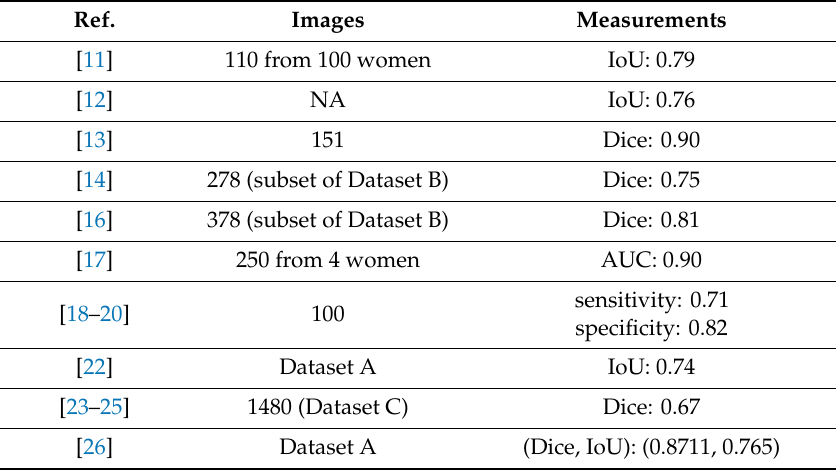
Table 3. Baseline performance for cervical region segmentation from previously reported studies.